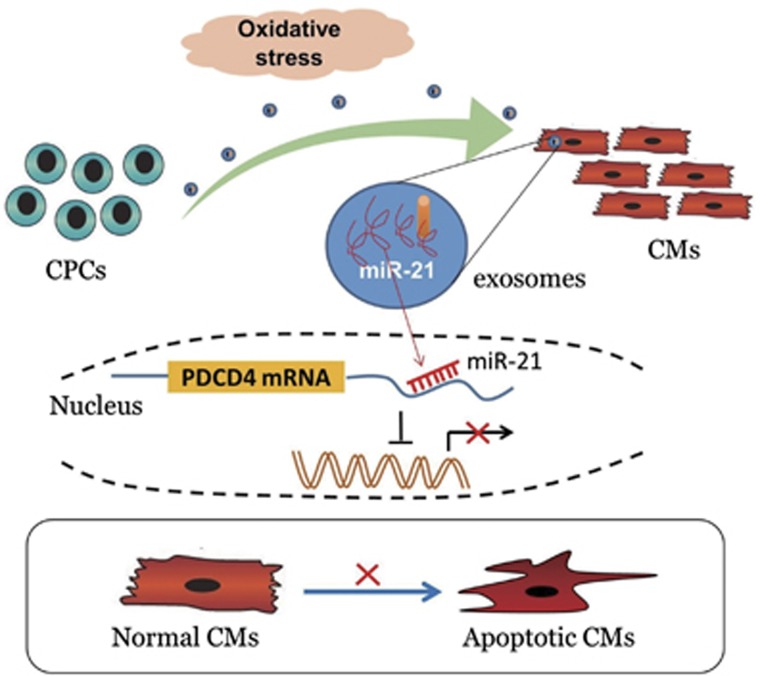
Schematic of our working hypothesis. In some oxidative stress-related cardiac injury, CPCs secreted a considerable amount of exosomes, which can be taken up by cardiomyocytes, and miR-21 contained in CPC-exosomes had an inhibiting role in the apoptosis pathway through downregulating PDCD4